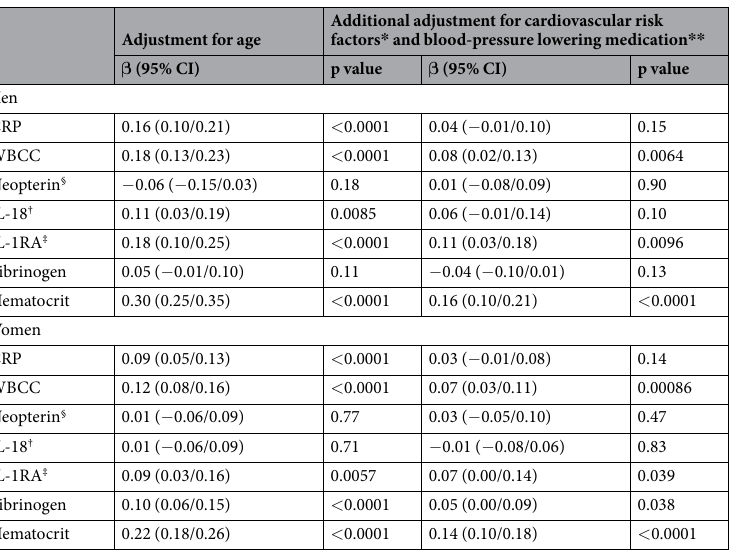
Table 3. Markers of Inflammation and Hemostasis and Arterial Stiffness: Results of Sex-specific Multivariable Linear Regression for Stiffness Index Among Individuals with Quantifiable Measurement (n = 12,650). Data represent β -estimates (per one SD increase in biomarker concentration) with 95% confidence interval. Models were calculated for each biomarker with stiffness index as dependent variable. CRP, IL-18, IL-1RA and neopterin were log-transformed for analysis. * Systolic and diastolic blood pressure, diabetes mellitus, obesity, smoking, dyslipidemia, family history of MI/stroke; ** blood-pressure lowering medication (ATC codes: C02, C03, C07, C08, C09); § n = 3,548 (1,886 men/1,662 women); † n = 4,078 (2,245 men/1,833 women); ‡ n = 4,442 (2,337 men/2,105 women). CI stands for confidence interval, CRP for C-reactive protein, WBCC for white blood cell count, IL-18 for interleukin-18, and IL-1RA for interleukin-1 receptor